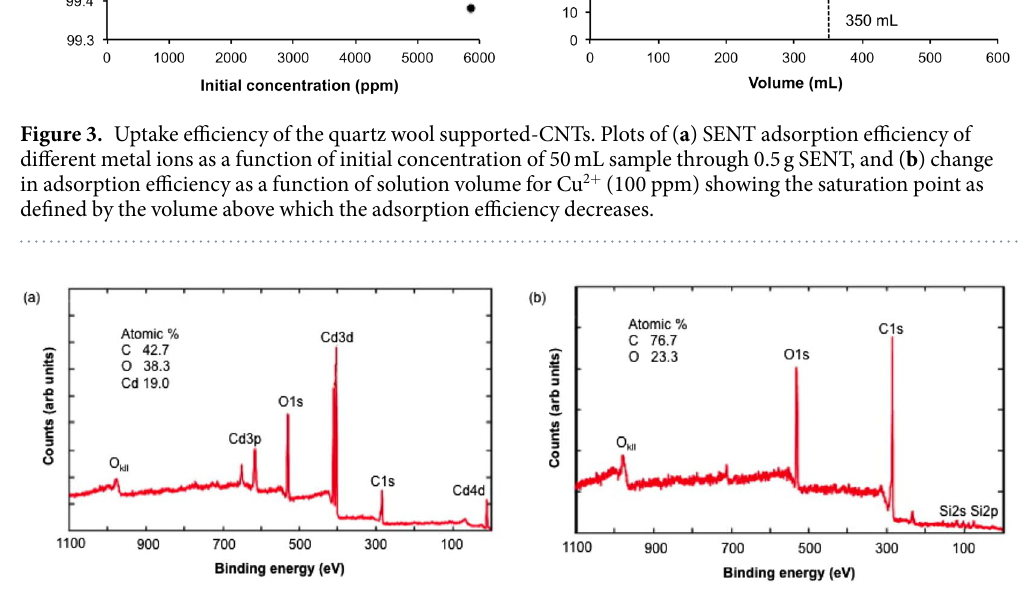
Figure 4. X -ray photoelectron spectra of the quartz wool supported-CNTs. XPS survey scans of ( a ) SENT after Cd 2 + adsorption and ( b ) after washing with acetic acid:water (1:1) showing the removal of the Cd 2 + and the underlying quartz (SiO 2